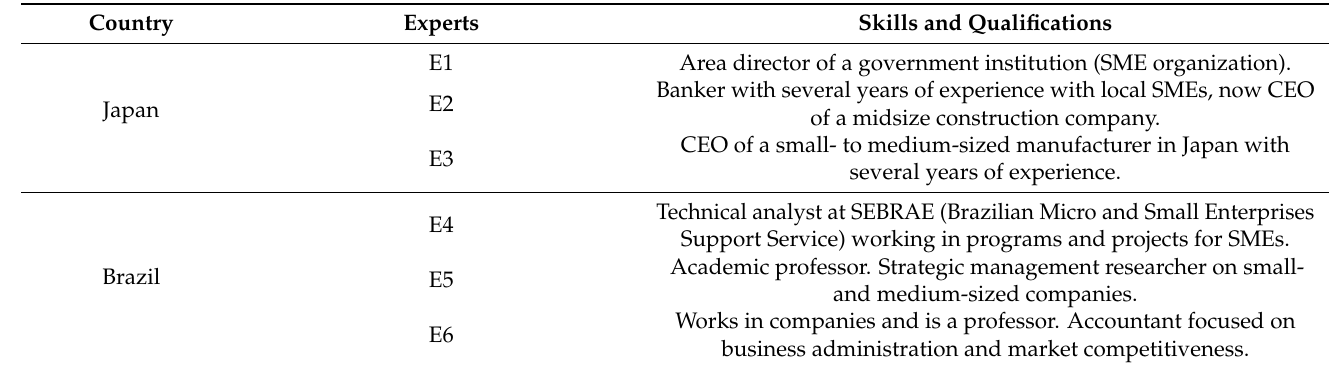
Table 4. Experts and the descriptions of their skills and qualifications.